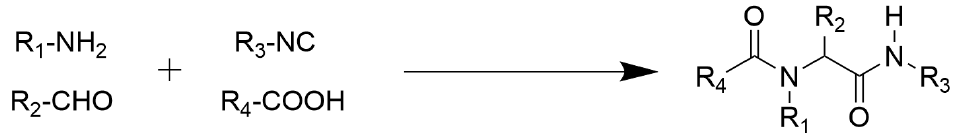
Figure 19. Diagram of the Ugi reaction.